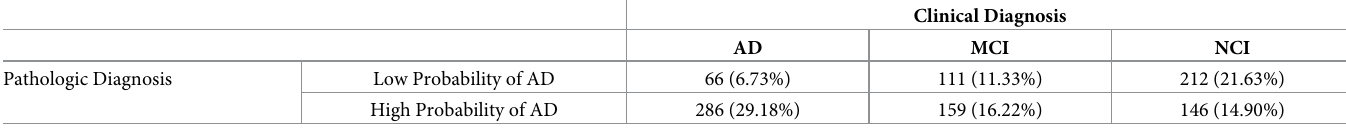
Table 1. A demographic summary for the n = 980 participants in terms of the premortem clinical diagnosis (i.e. AD, MCI, and NCI) as well as the postmortem path- ologic diagnosis (i.e. the modified NIA-Reagan